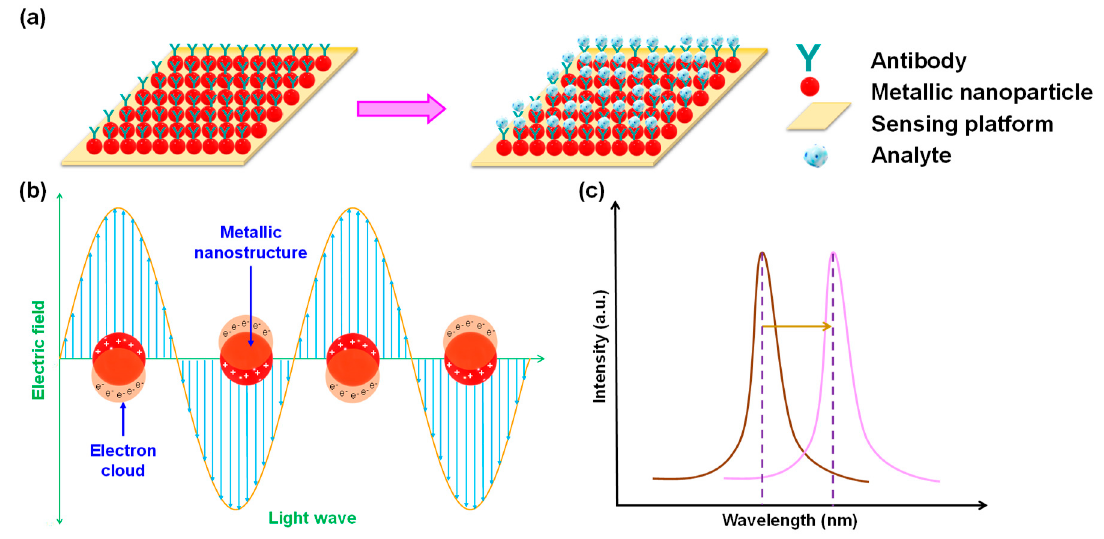
Figure 6. ( a ) LSPR-based direct assay; ( b ) Principle of LSPR; ( c ) Shifting of the LSPR extinction peak to higher wavelength from an analyte free state (brown curve) to analyte bound state (pink curve).